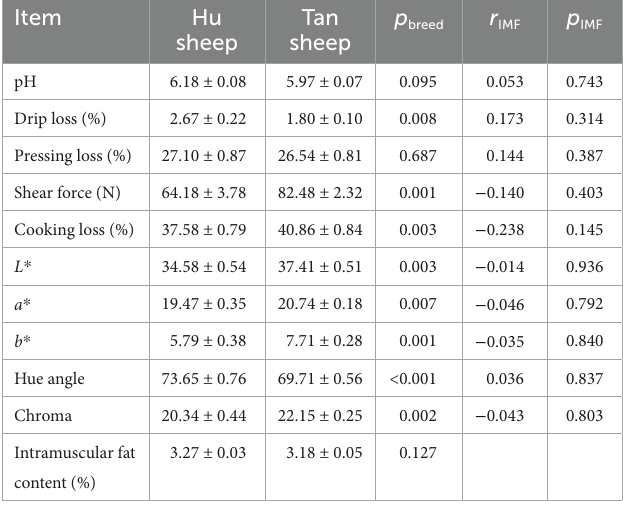
TABLE 2 Meat quality characteristics and intramuscular fat of psoas major muscles from Hu and Tan sheep ( n = 20). Hu